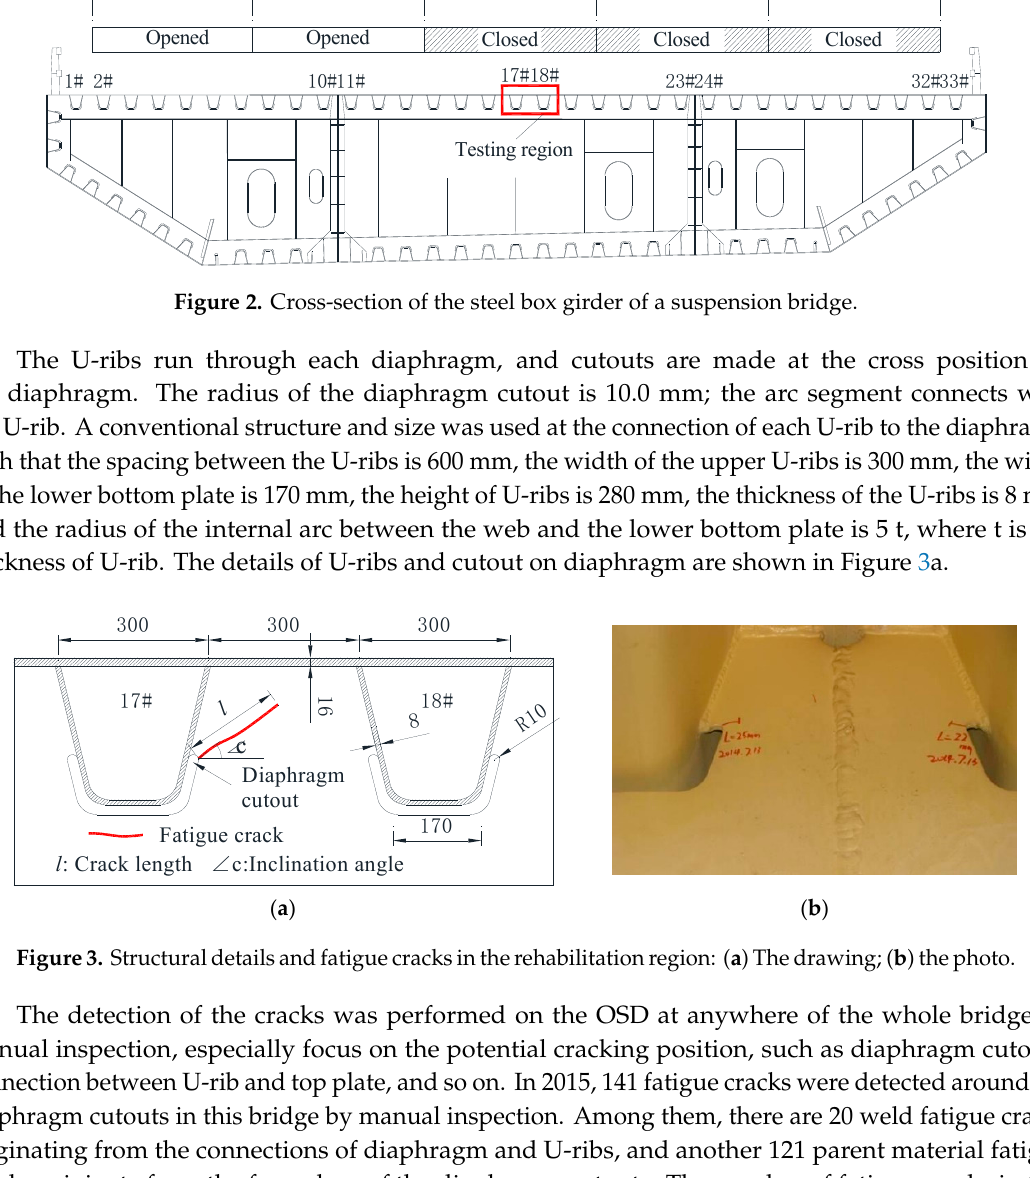
Table 1. Fatigue crack characteristics and quantity in